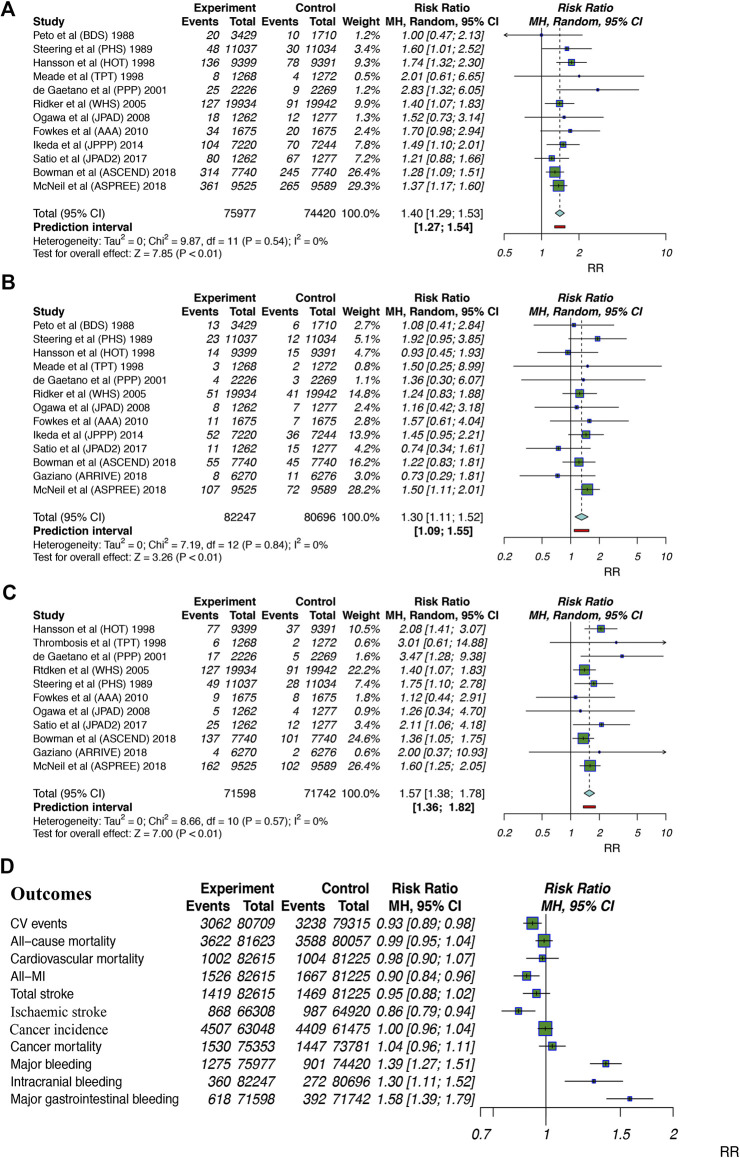
Summary forest plots for the outcomes of bleeding. (A) Forest plot for major bleeding. (B) Forest plot for intracranial bleeding. (C) Forest plot for major gastrointestinal bleeding. (D) Forest plot for summarized outcomes analyzed in the current study. MI, myocardial infarction; 95% CI, 95% confidence interval.